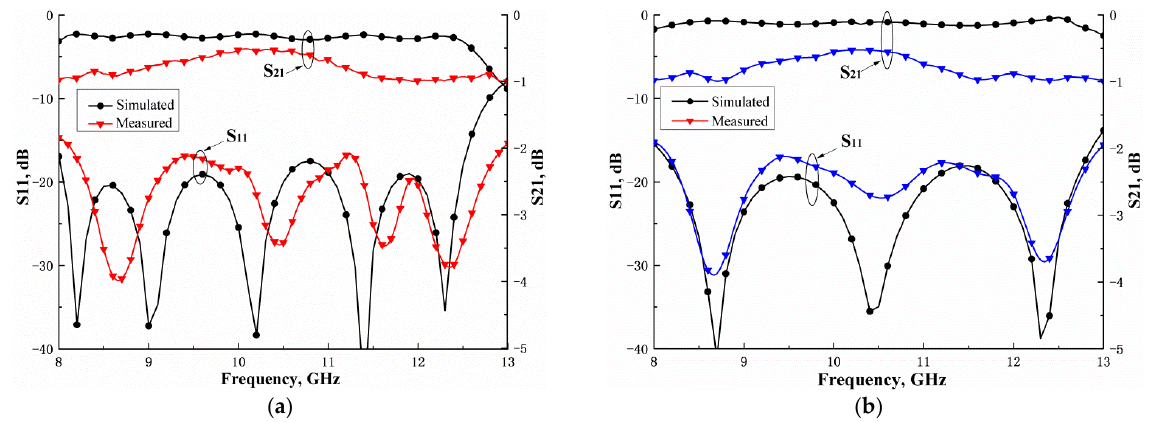
Figure 6. Measured and simulated results for the back-to-back transition: ( a ) ( ε r = 10.2); ( b ) ( ε r = 2.22).